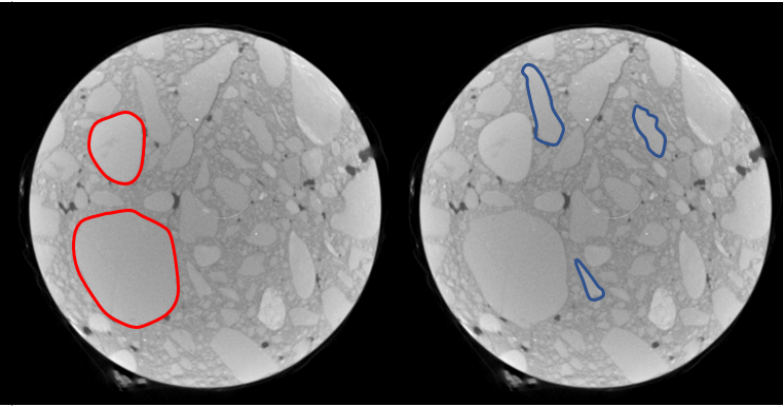
Figure 11. Spherical aggregates ( left ) and needle-like aggregates ( right ).